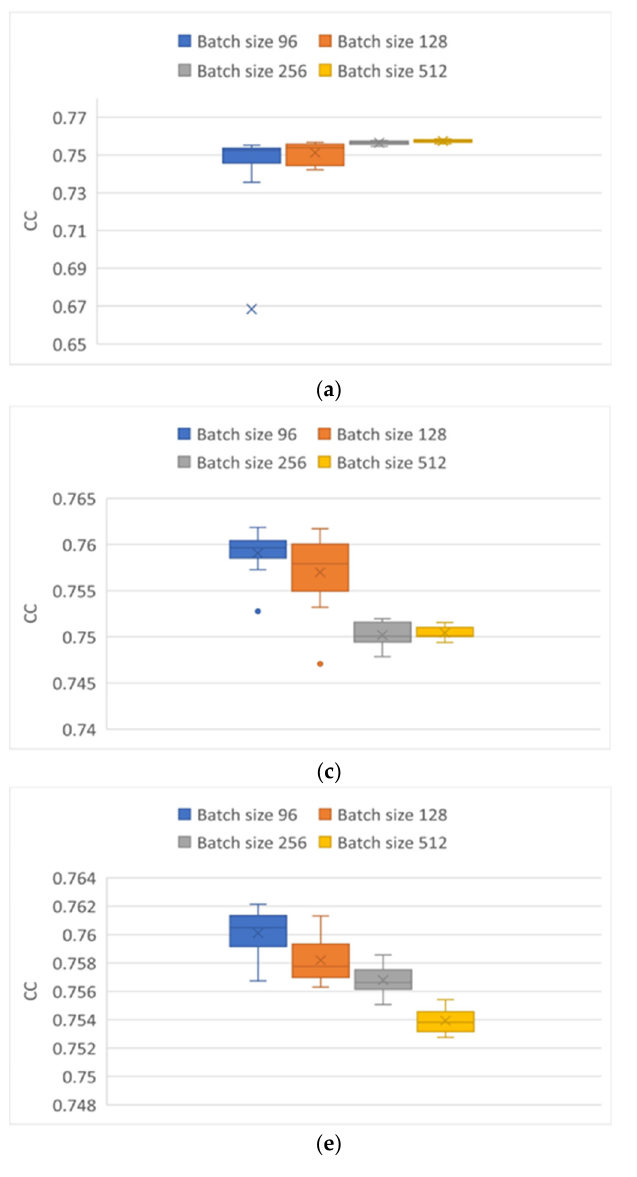
Figure 8. CC variability obtained from modeling PM 2.5 particle. ( a ) Elman neural network using Adam optimizer. ( b ) Elman neural network using Adamax optimizer. ( c ) GRU neural network using Adam optimizer. ( d ) GRU neural network using Adamax optimizer. ( e ) LSTM neural network using Adam optimizer. ( f ) LSTM neural network using Adamax optimizer.